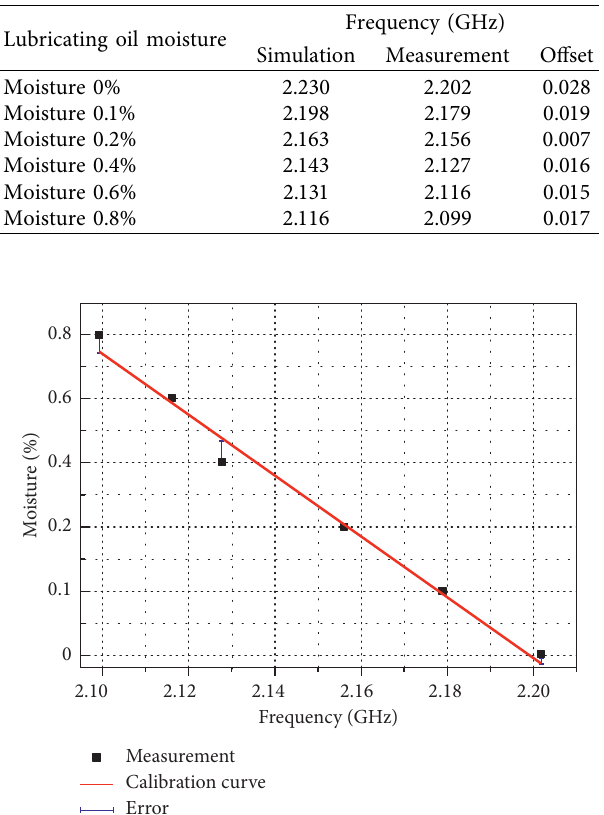
Table 2: The resonance frequency changes between the simulation and measurement of lubricant oil with different moisture contents.